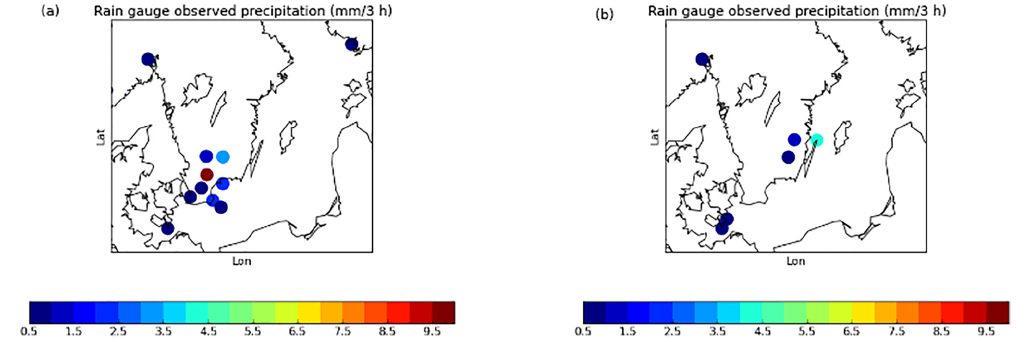
Figure 13. Rain-gauge-observed 3h accumulated precipitation (unit mm(3h) − 1 ) from accumulation period starting on 24 June 2016 at 23:00UTC (a) and on 25 June 2016 at 02:00UTC (b)